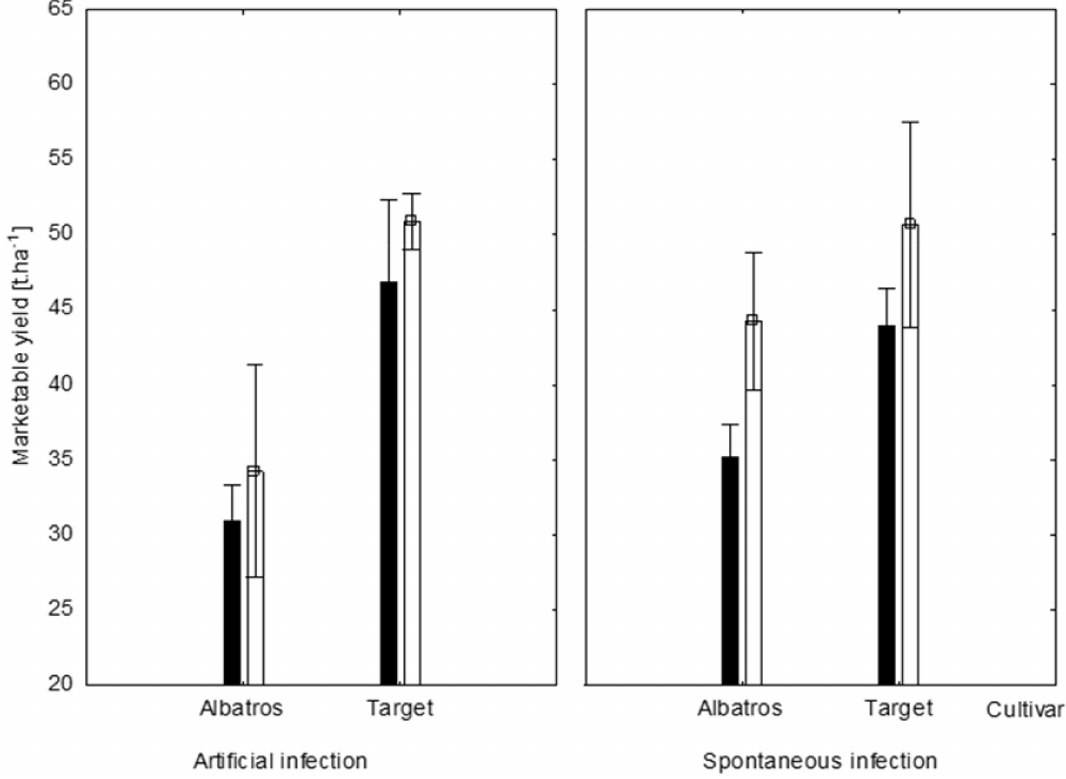
Figure 2. Effects of production system and fungal infection on the crop yield of Albatros and Target cultivars. Integrated system (unshaded columns), ecological system (shaded